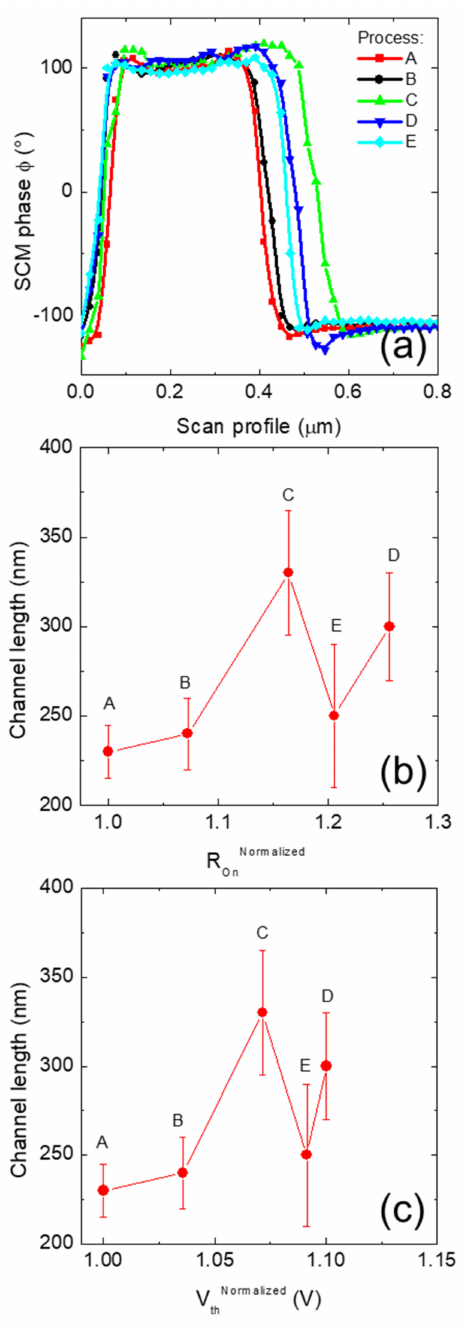
Figure 7. ( a ) SCM phase φ vs. scan profile averaged over 10 µ m. Channel lengths vs. R On ( b ) and vs. V th ( c